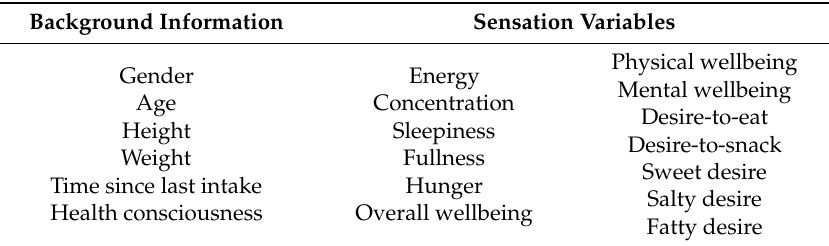
Table 2. Questionnaire variables.